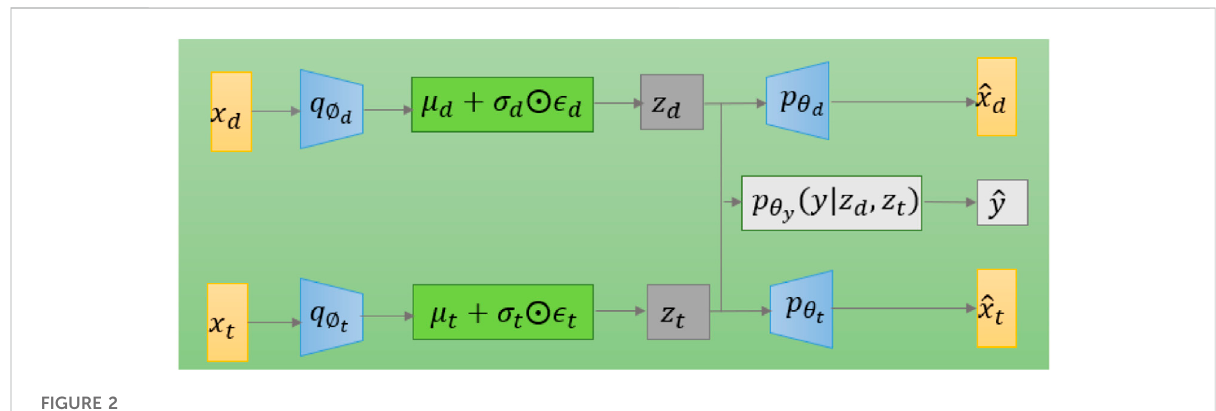
FIGURE 2 The graphical structure of the VAE model for DPIs